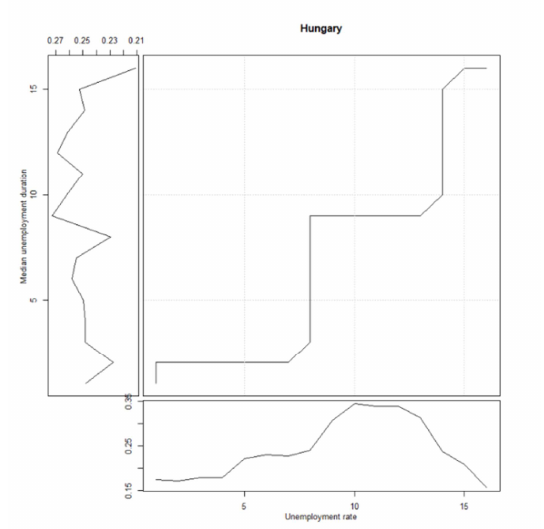
Figure 11. Alignment plots for the unemployment rate and lagged median unemployment duration for